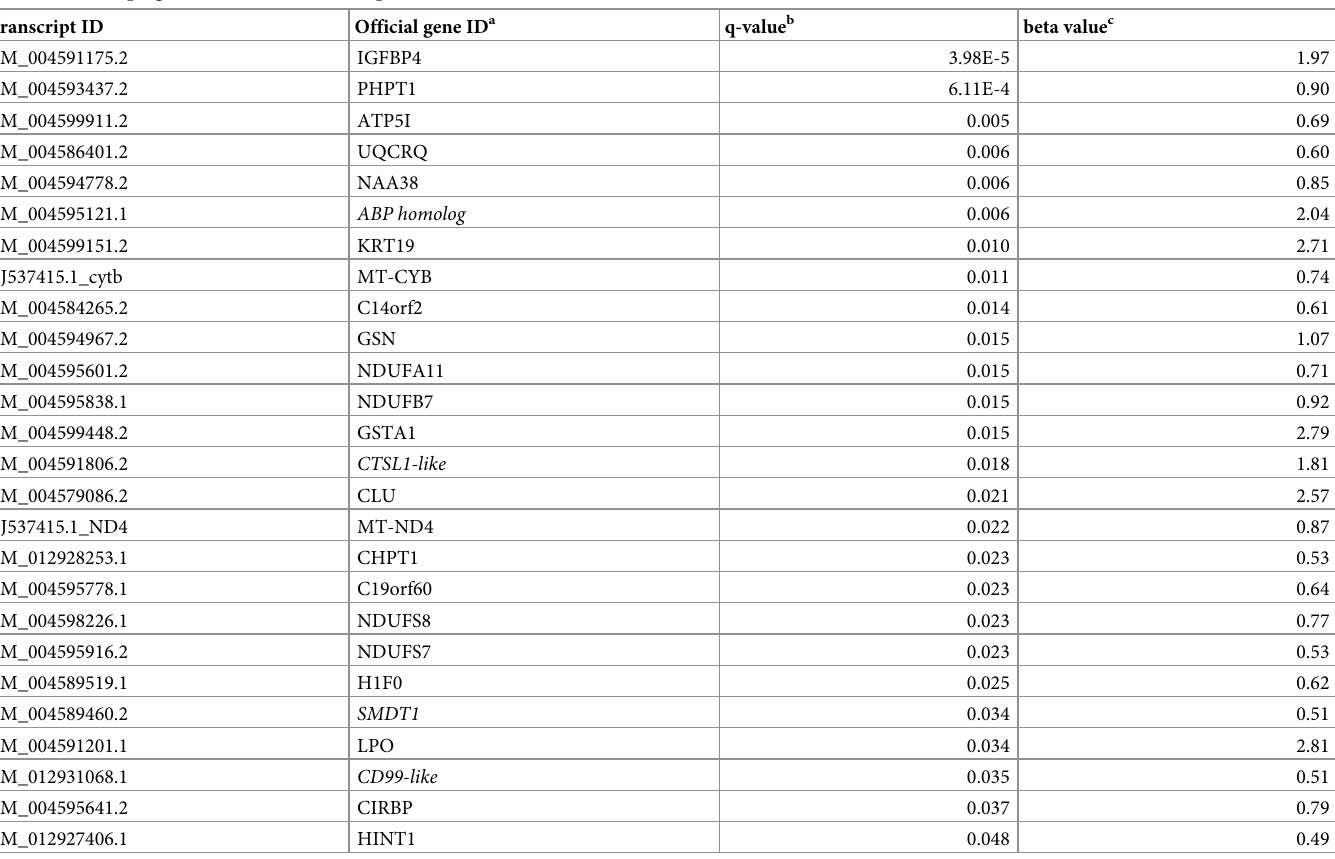
Table 2. Genes upregulated in the 5,000 m